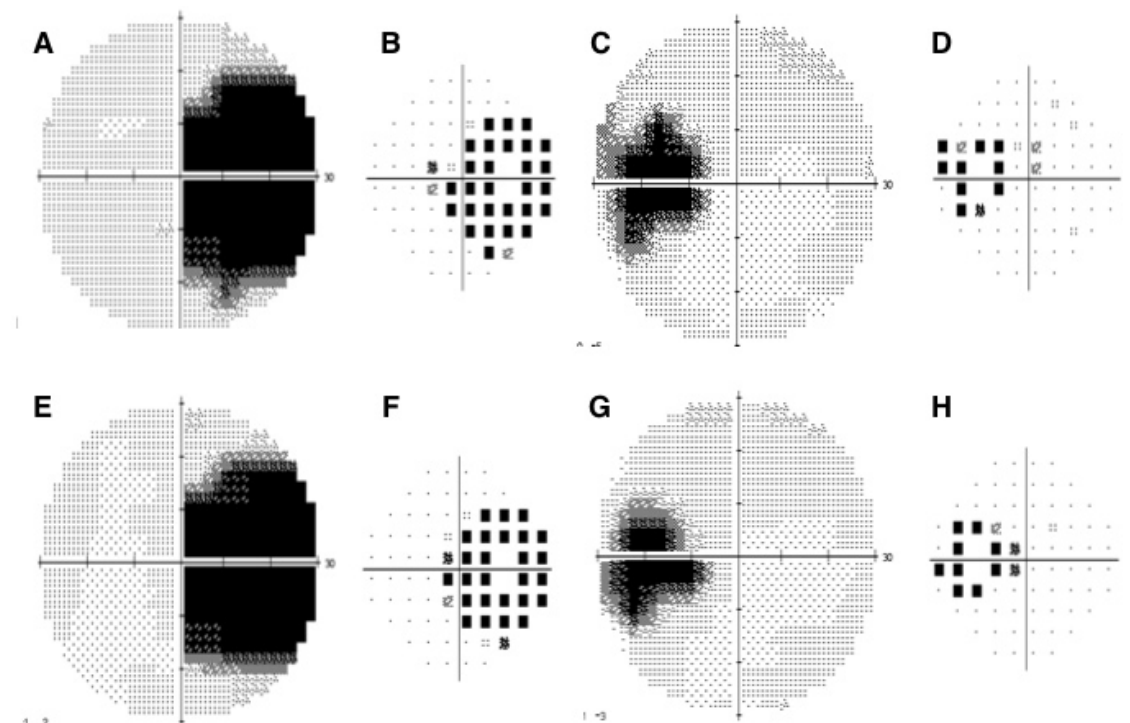
Figure 3: At baseline, HVF showing enlargement of blind spot with few temporal focal field defects in the right (A, B) and left eye (C, D). At 3-month follow-up, HVF shows a marginal reduction of scotoma in the right (E, F) and left (G, H)